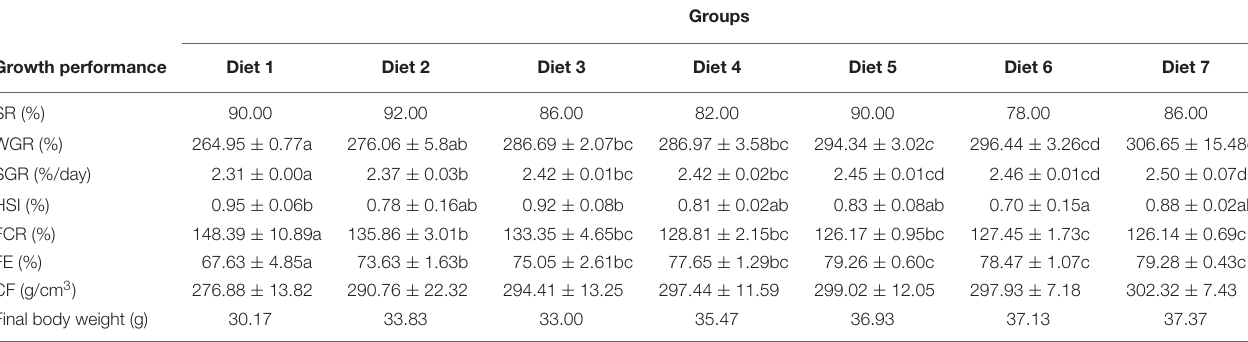
TABLE 4 | Effect of different diets on growth performance of Trachinotus